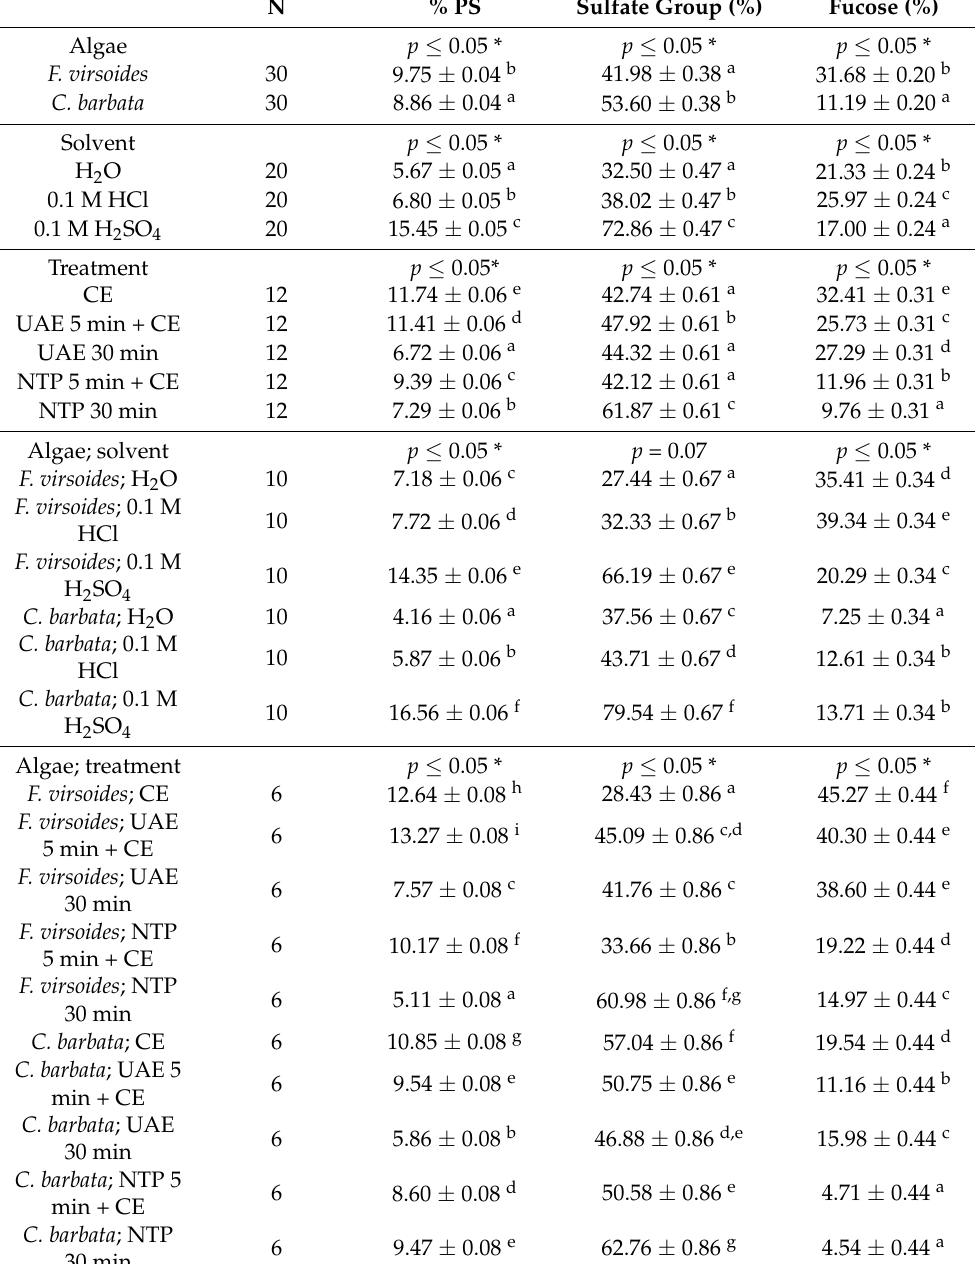
Table 2. Influence of the algae species, extraction solvent, and extraction treatment on polysaccharide yield (%PS), sulfate group, and fucose content of the extracted